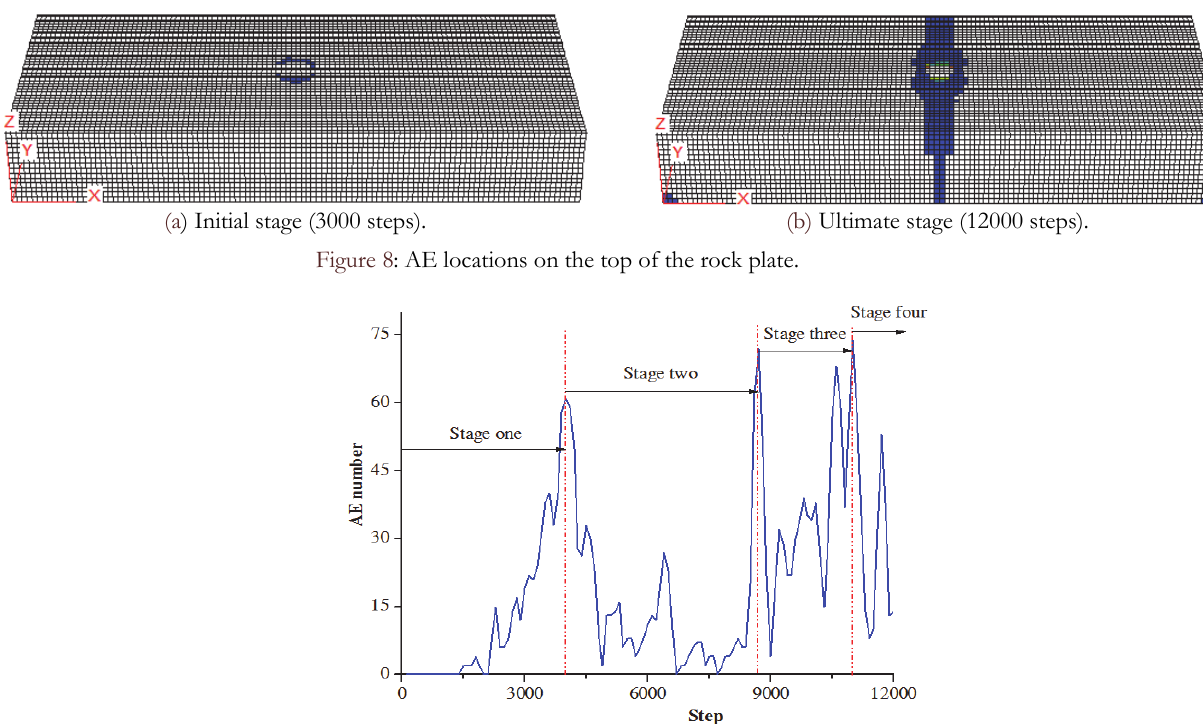
Figure 9: AE hits-step curve in the numerical